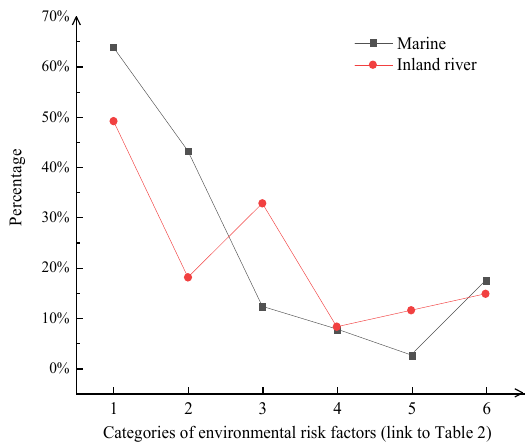
Figure 7. Proportion of Sub-Factors of Marine and Inland Ship Factors.